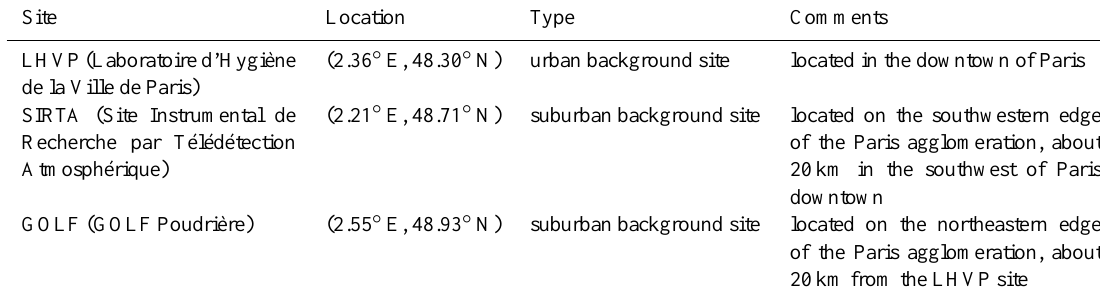
Table 1. Description of the three ground-based primary measurement sites during the MEGAPOLI campaigns.